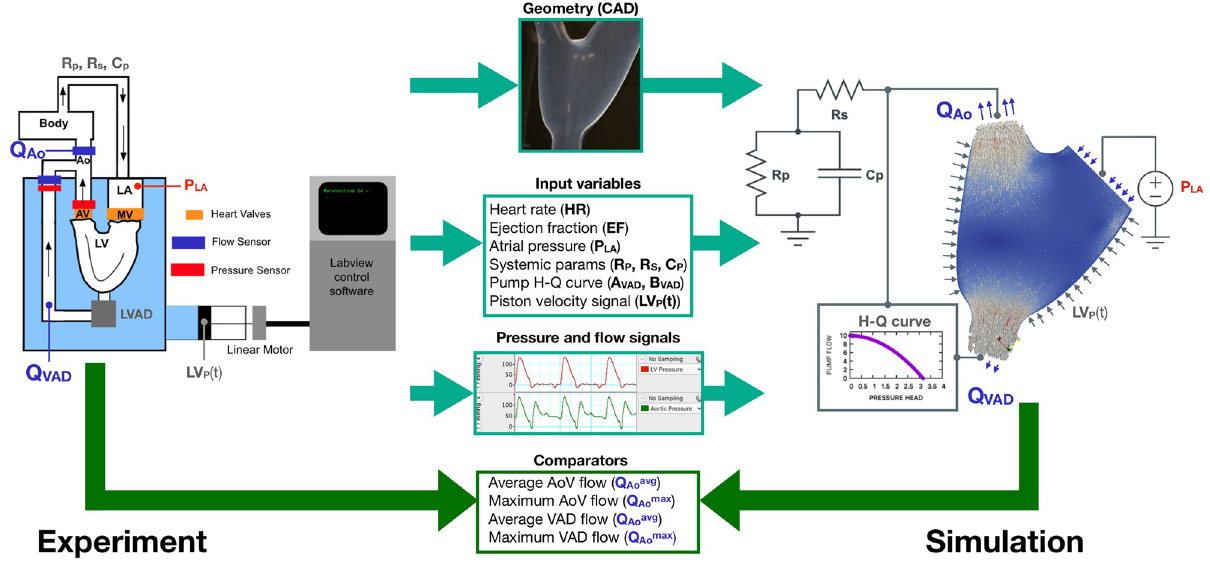
Fig 1. Leftmost side: Schematic of the experiment setup. LA: left atrium, MV: Mitral valve, AV: Aortic valve, Ao: aorta. Flow and pressure sensors are indicated in blue and red respectively. The body lumped system is afterwards characterised with a three element Windkessel model with parameters R p , R s and C p . Center: variables extracted from the benchtop experiment to create the simulation and address the uncertainty quantification (UQ). Rightmost side: Schematic of the simulation, including the lumped models for the boundary conditions. The measured P valve. The measured R p , R s and C p are used in a three element Windkessel boundary condition at the Aortic valve output. The H-Q curve retrieved and measured is used as a dynamic boundary condition in the LVAD outflow. The benchtop piston dynamics is used as boundary condition for the deformable LV